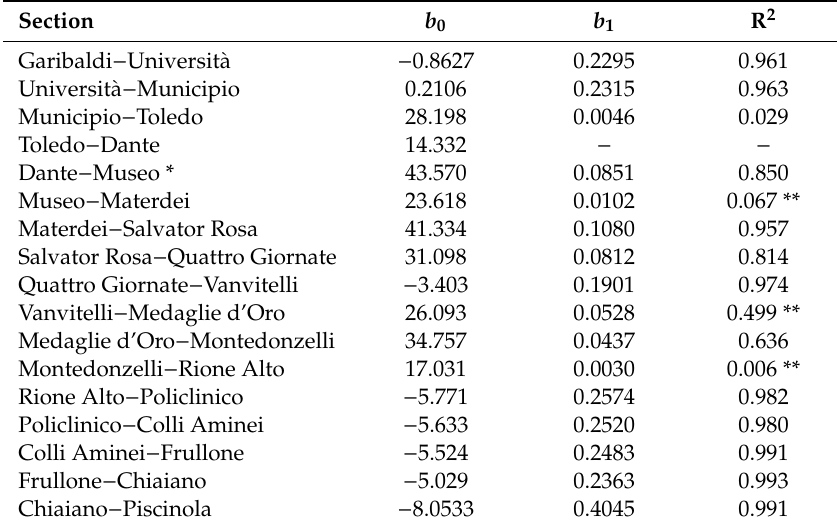
Figure 8. Examples of the relationship between energy consumed and cruising speed. 5. Solution Approaches and Numerical Results For solving the optimisation model (1–4), we propose two different approaches. The first is based on using a generalised reduced gradient (GRG) algorithm. In this case, the possibility of on-line delays is not considered in any way and the values obtained, thus, represent ideal ones. It is expected that it is not always possible to reach such values because, as stated above, the optimal cruising speed can be used on the section only if the train is not delayed. The second approach consists in implementing the line through a discrete simulation model, built, in our case, with Arena software [45] and Optquest for Arena [46], which is an optimisation module that can be used in Arena. It is thereby possible to include in the model some delay travel time functions on every section and simulate, should the delay of one train be such as to prevent the next train occupying the same section, the propagation of the delay to the following trains. The functions calibrated in Section 4 were used in both cases and the following assumptions, considering the real operation of the metro line, were considered: (i) Dwell times of 20 s at each station; (ii) a reserve time of 240 s at each terminal.